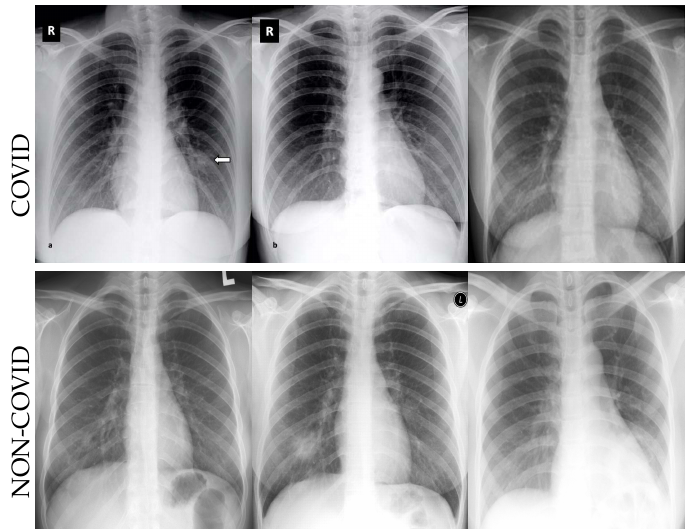
Figure 2. Samples from the COVIDx [2] dataset. The upper row shows examples with COVID-19, while the lower row presents images without COVID-19’s